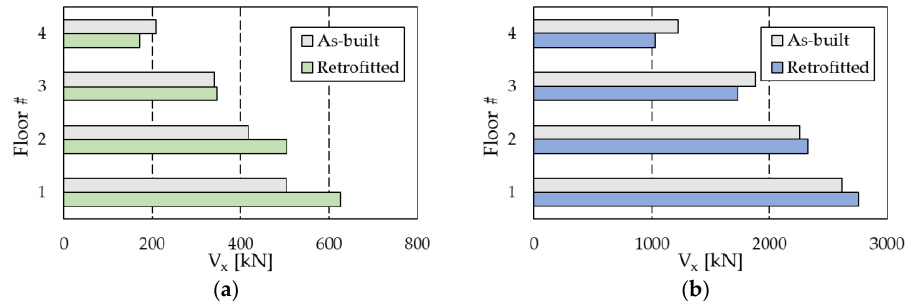
Figure 18. Maximum shear force V in the X-direction: ( a ) RC structure, and ( b ) steel MRF.